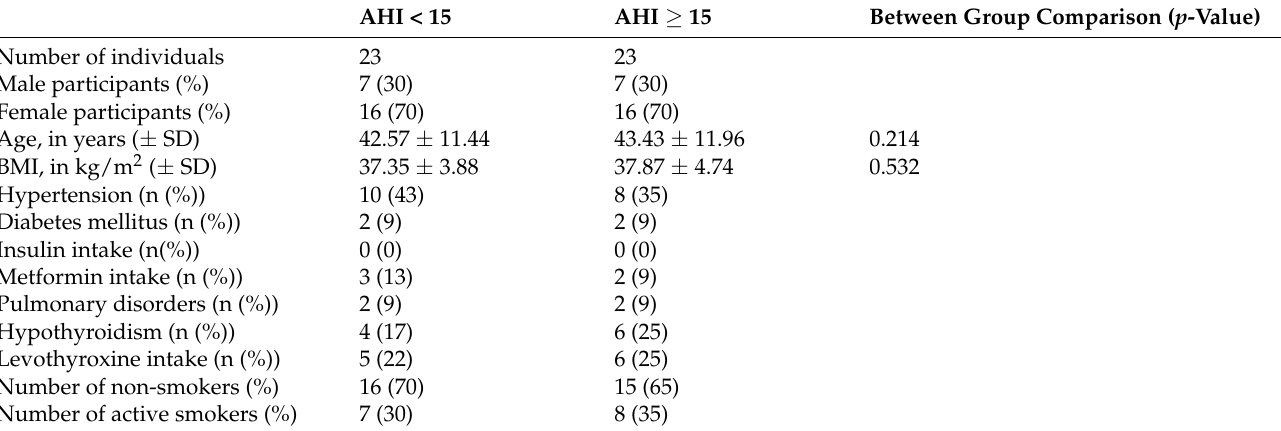
Table 1. Baseline